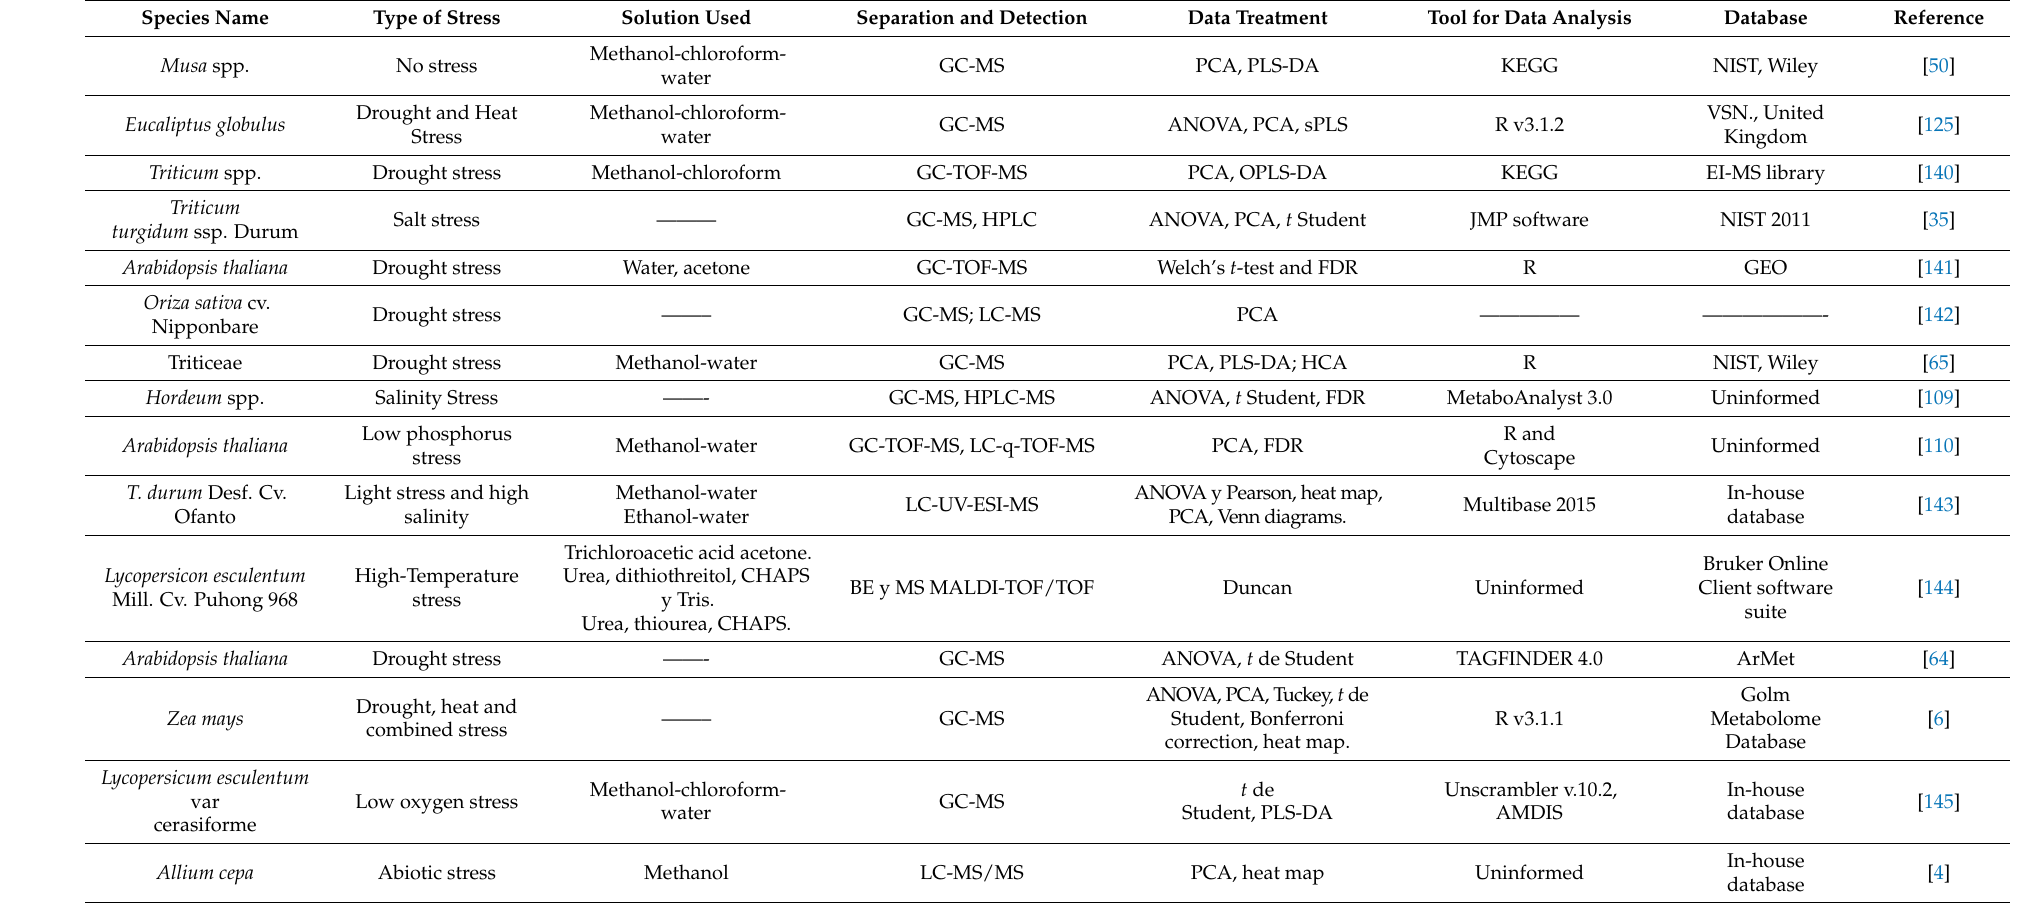
Table 2. Contributions to metabolomics for understanding abiotic stress in